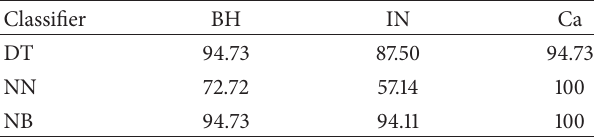
Table 7: F -score (%) of each ABC